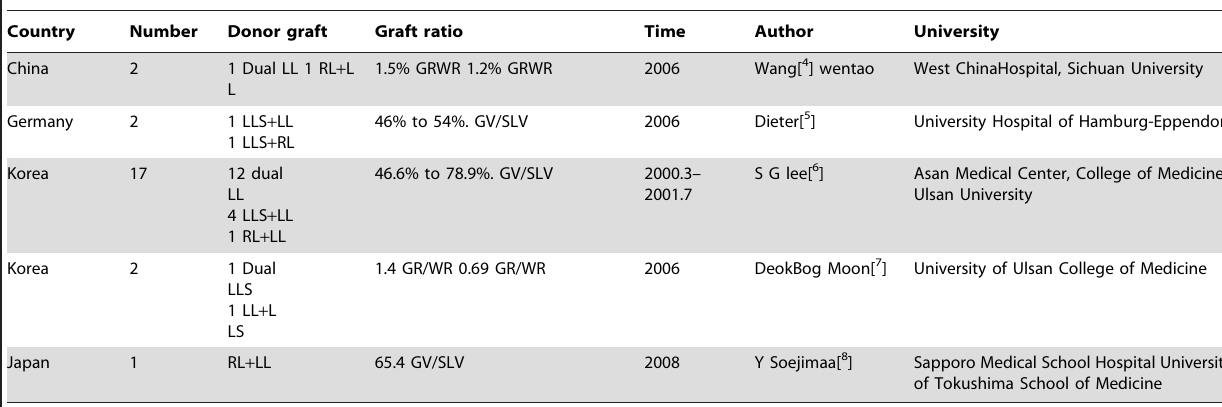
Table 1. Dual liver transplantation history.